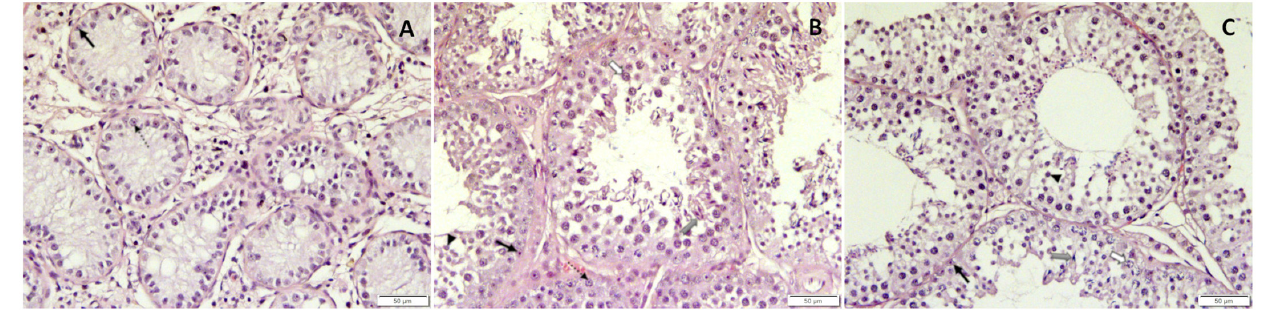
Figure 12. Histomorphology of testicular tissue after treatment with a deslorelin implant ( A , B ) or saline I. Whereas ( A ) represents an arrest of spermatogenesis on the level of mainly spermatogonia five months after treatment with the deslorelin implant (D ex, right testis), ( B ) clearly shows recovery with normal spermatogenesis being present at the end of the observational period (left testis). In ( C ), normal spermatogenesis of a saline-treated control at the end of the observational period is shown. spermatogonia; spermatocytes; round spermatids; elongating spermatids; Sertoli cells.